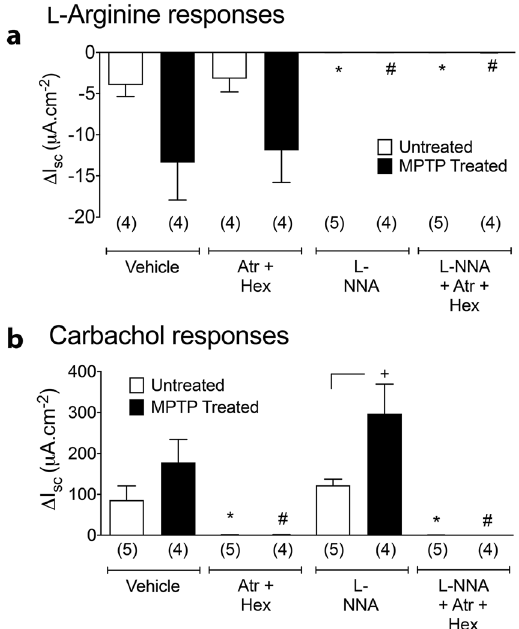
Fig. 4 Changes in the short cuircuit current (I SC ) in the presence of L-arginine or carbachol in transverse colon mucosa from naïve or MPTP-treated animals. a L-Arginine (200 µM) and b carbachol (10 µM). Values are mean ± SEM from the numbers of animals shown in parentheses. ( a , b ) * P ≤ 0.05 compared to vehicle in naïve animals; # P ≤ 0.05 compared to vehicle in MPTP-treated animals (ANOVA with Dunnett ’ s